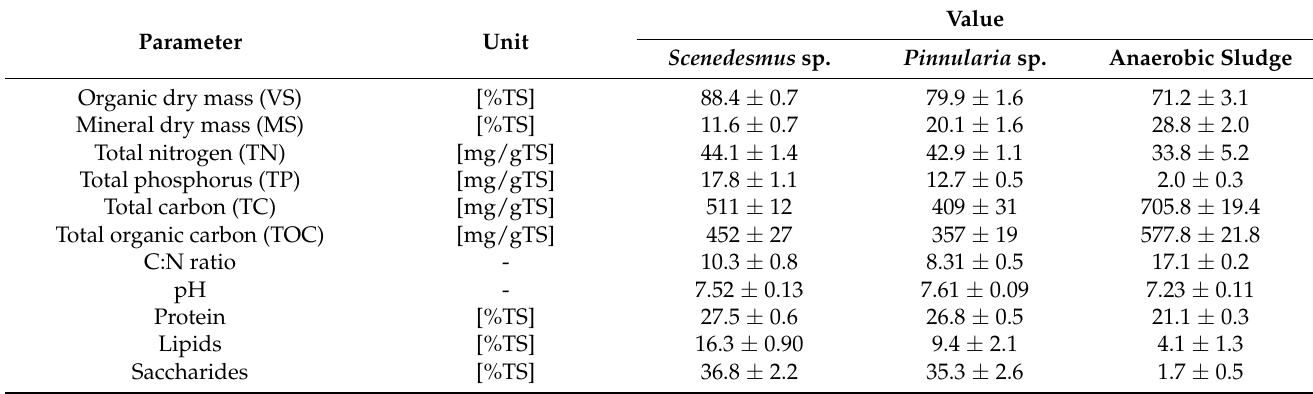
Table 5. Profile of the microalgal biomass and anaerobic